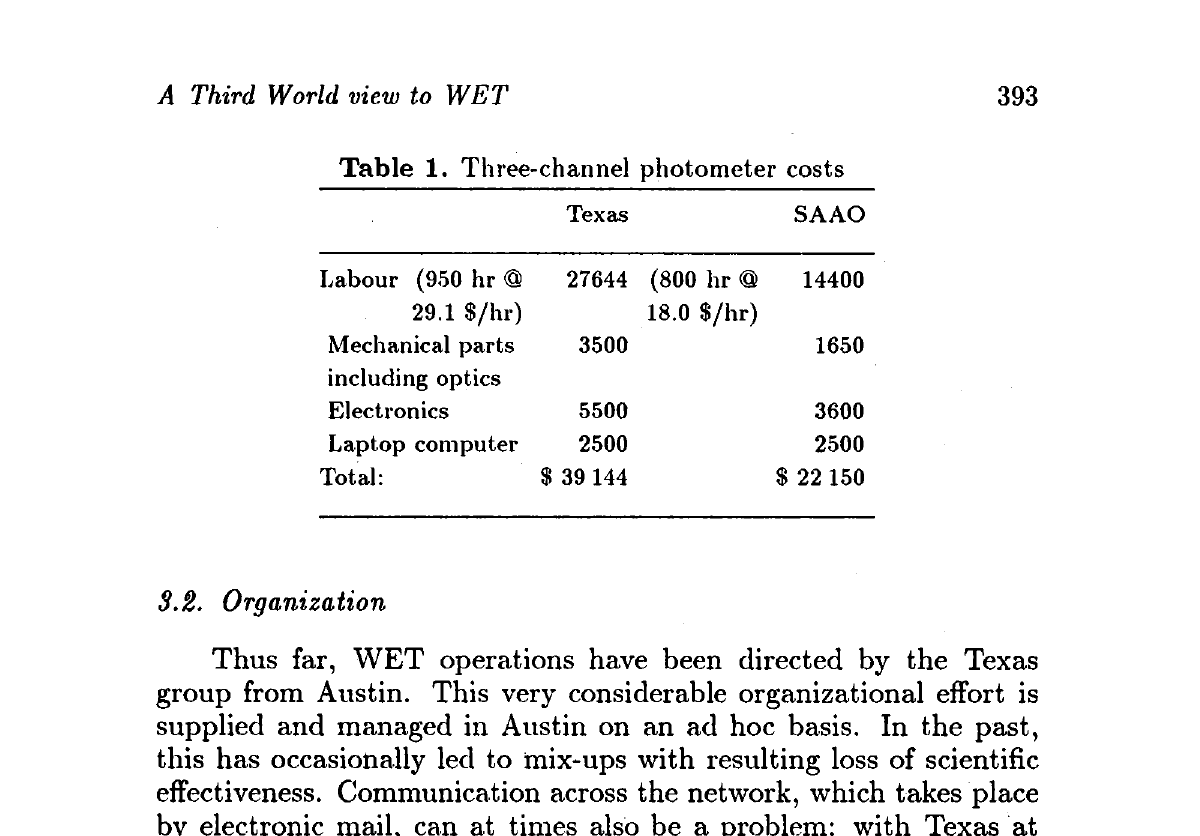
Table 1. Three-channel photometer